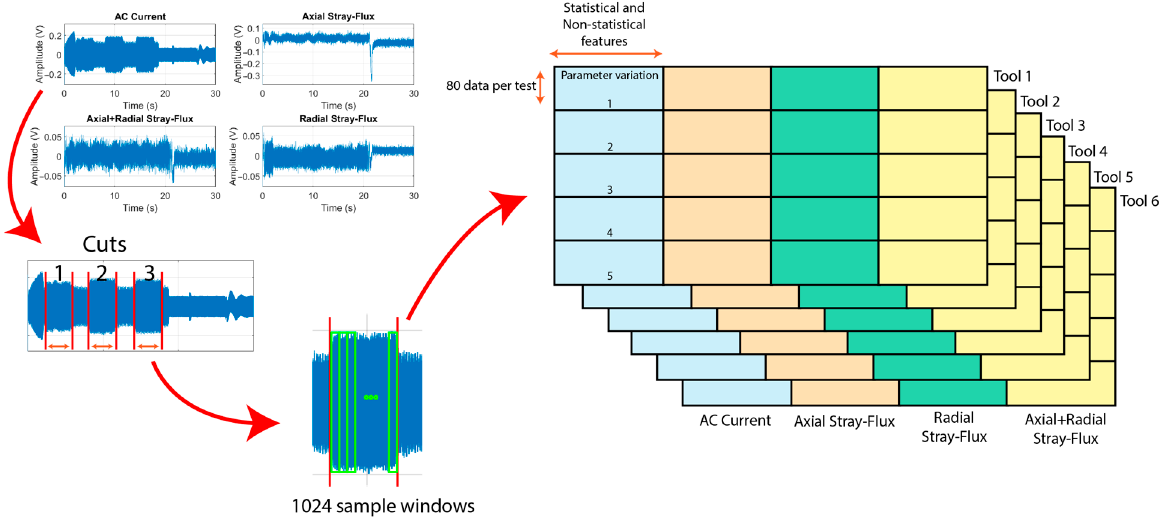
Figure 6. Stray flux and current signal feature extraction process.